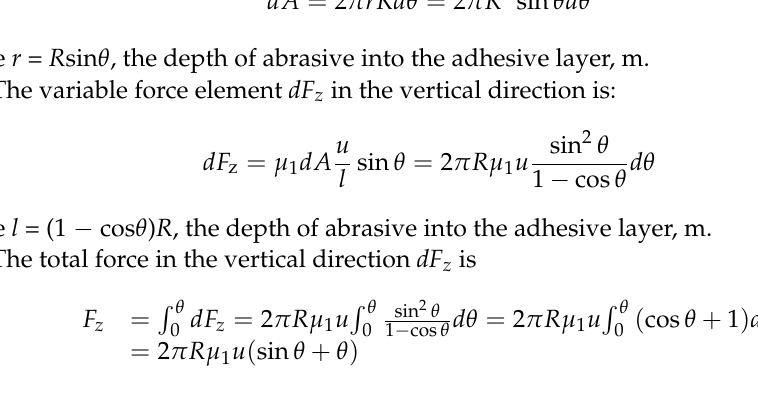
Figure 3. Diagram of viscous force.